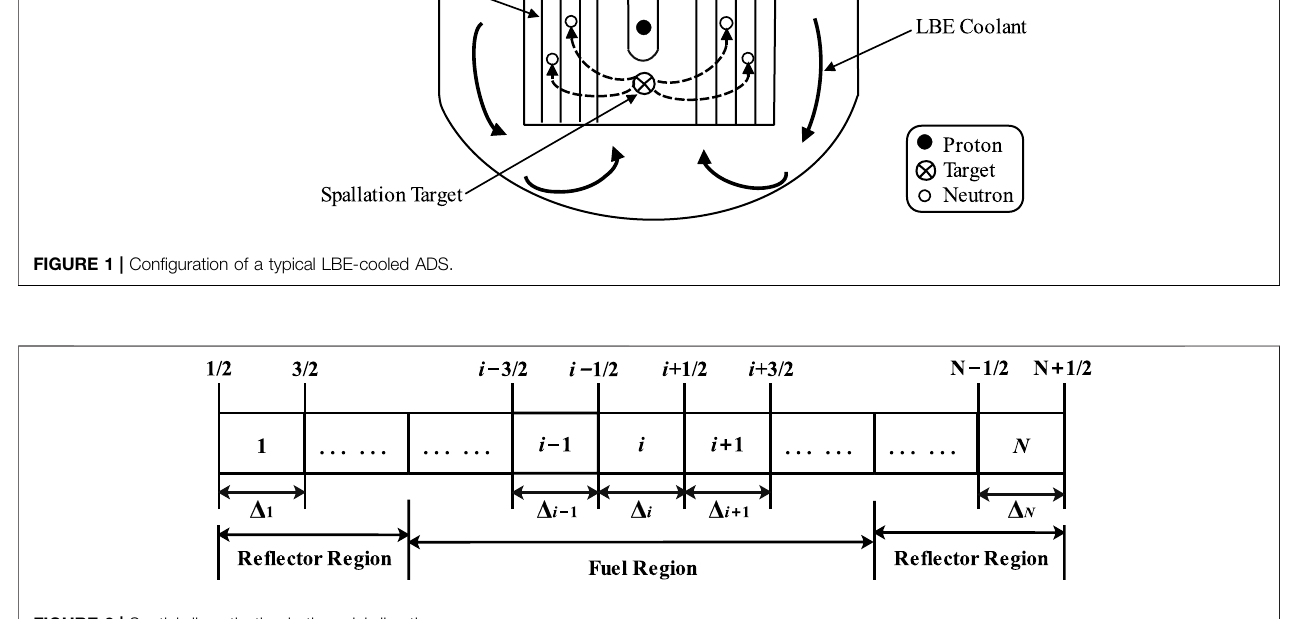
FIGURE 2 | Spatial discretization in the axial